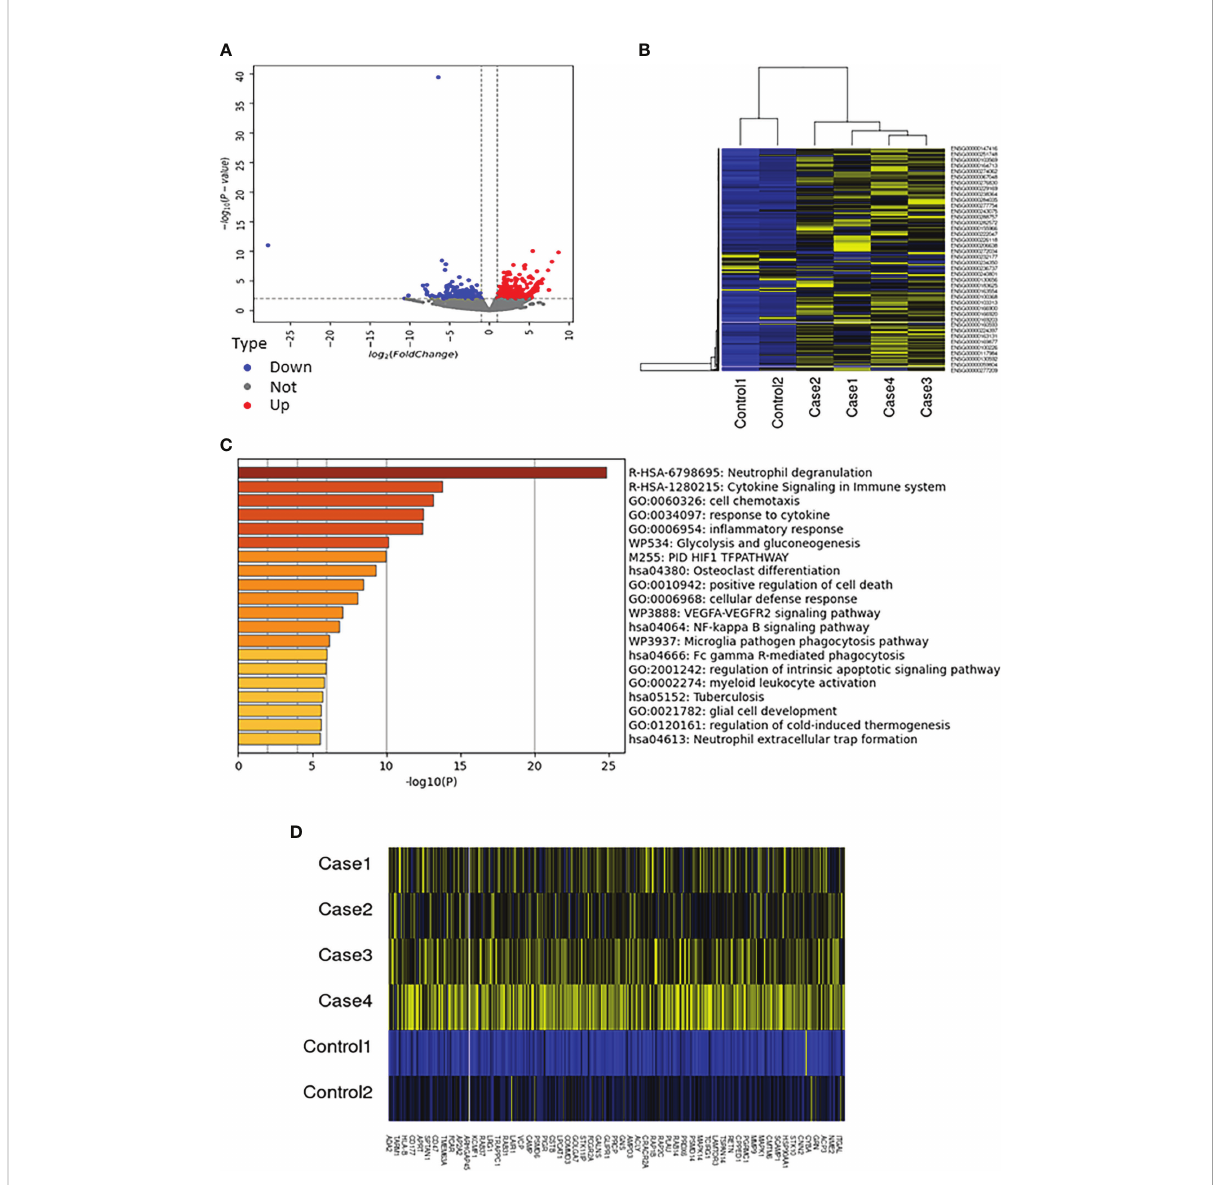
FIGURE 1 Genes associated with neutrophil degranulation and cytokine signaling were signi fi cantly elevated in the unknown group. (A) Volcano plots showing signi fi cantly different expressions of genes between the unknown and control groups (p<0.01). Red points, upregulated differentially expressed genes; blue points, downregulated differentially expressed genes; gray points, genes with no signi fi cant differences in expression. (B) Heatmap of different expressions of genes between the unknown and control groups (p<0.01). Yellow represents upregulation and blue represents downregulation. (C) The GO terms and KEGG pathways enrichment analysis for signi fi cantly upregulated genes between the unknown and control groups (p<0.01). (D) Heatmap of genes involved in neutrophil degranulation between the unknown and control groups. Yellow represents upregulation and blue represents